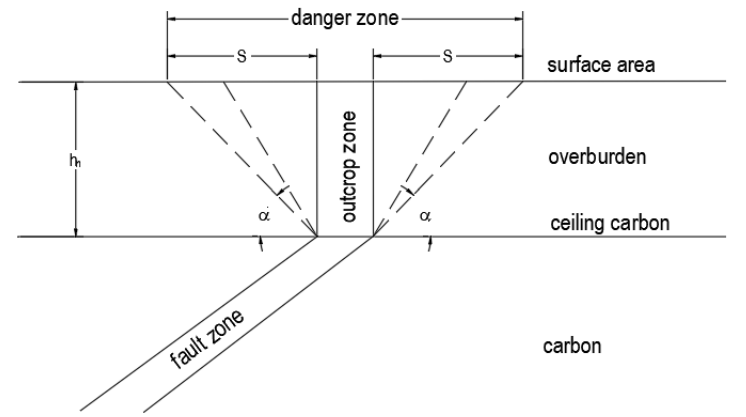
Figure 8. Width of the zone threatened by occurrence of discontinuous deformations in the area of fault outcrops. Adapted from [4].